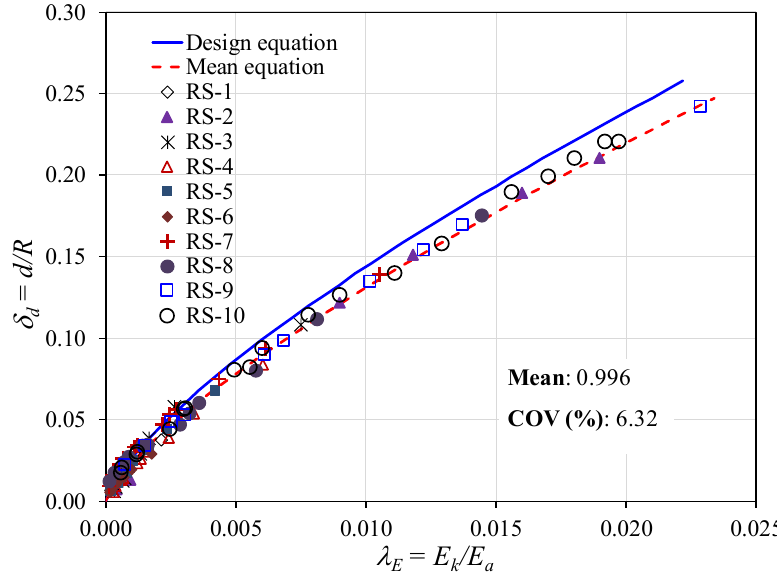
Figure 20. Tendencies of d / R with non-dimensional basic parameters Z and √ ring-stiffened cylinder.